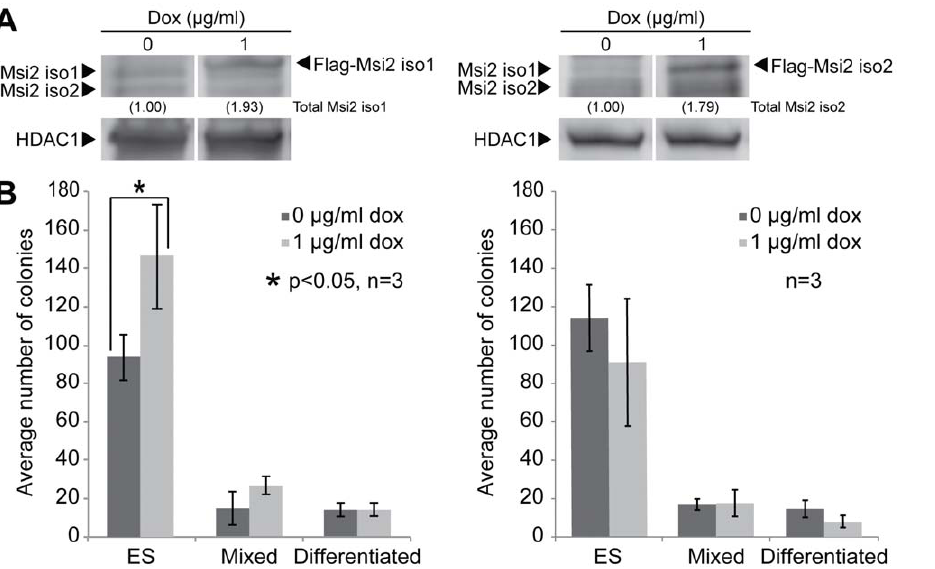
Figure 5. Overexpression of Msi2 in ESC increases the cloning efficiency of ESC. ( A ) Western blot analysis of Msi2 present in D3 ESC stably infected with a lentivirus for the inducible expression of Flag-tagged Msi2 isoform 1 (left) or Flag-tagged Msi2 isoform 2 (right) in the presence of 1 m g/ml Dox. ( B ) Effects of inducing Flag-tagged Msi2 isoform 1 (left) or Flag-tagged Msi2 isoform 2 (right) on the cloning efficiency of D3 ESC. The cells were plated at clonal density (200 cells per cm 2 ) and exposed to 1 m g/ml Dox for 5 days. The error bars are standard error of the mean. This experiment was repeated twice and similar results were obtained.